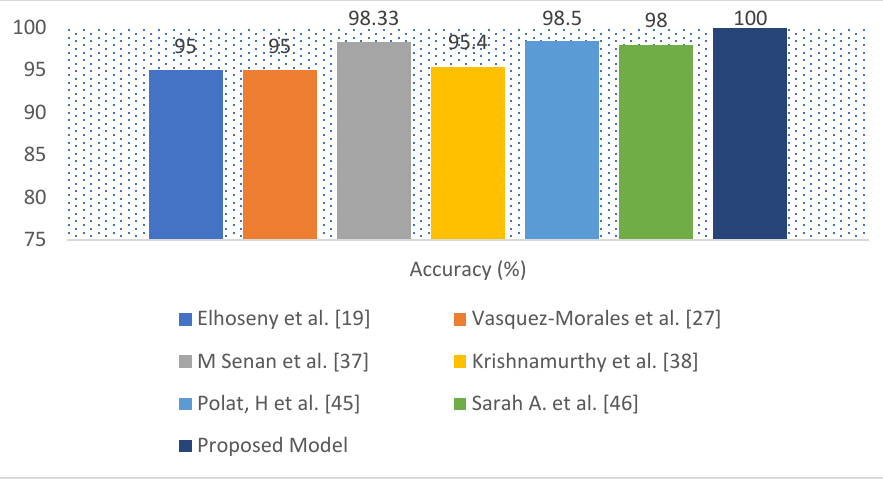
Table 6. Comparative analysis of the proposed model with existing models from the literature on the UCI data set.